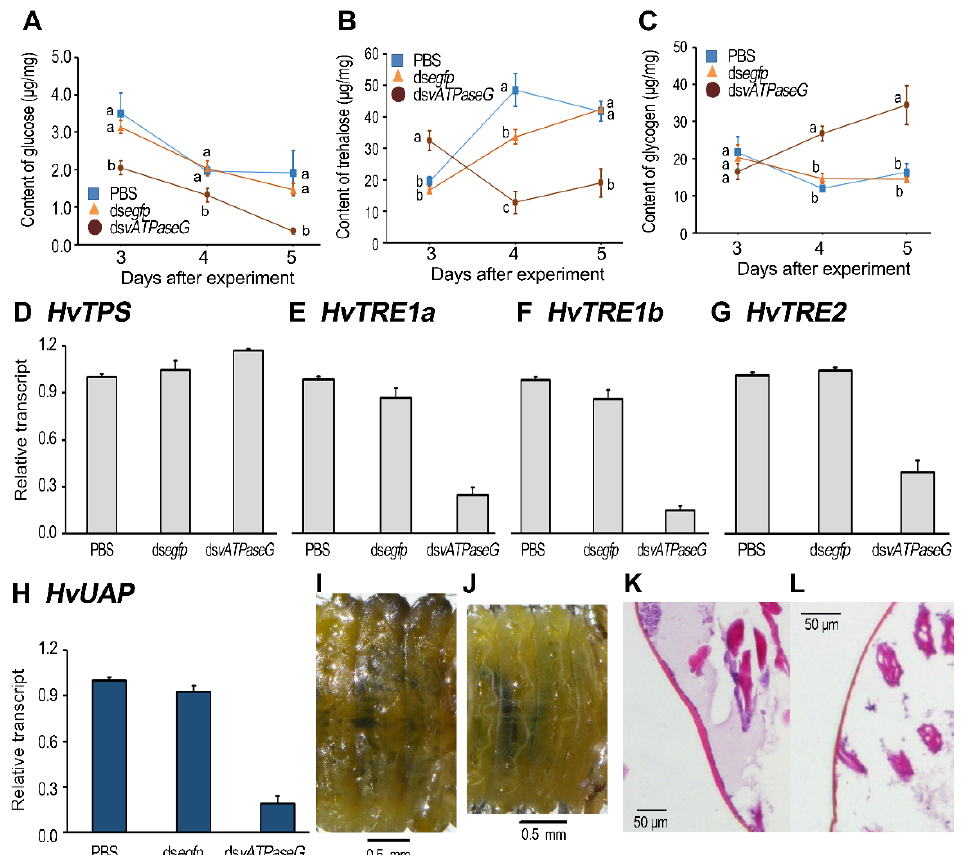
Figure 5. Knockdown of HvvATPaseG affects sugar contents in Henosepilachna vigintioctopunctata . The newly-ecdysed final instar larvae had ingested PBS-, ds egfp -, and ds vATPaseG -dipped leaves for three days. The specimens 3, 4 and 5 days after experiment were collected and the contents of glucose, trehalose and glycogen were determined ( A – C ). The expression levels of a trehalose biosynthesis gene ( HvTPS ), three trehalose degradation genes ( HvTRE1a , HvTRE1b and HvTRE2 ) and a chitin biosynthesis gene ( HvUAP ) were tested ( D – H ). Relative transcripts are the ratios of relative copy numbers in treated individuals to PBS-fed controls, which are set as 1. The bars represent values ( ± SE). Different letters indicate significant difference at p value < 0.05 using analysis of variance with the Tukey-Kramer test. The body cuticle was almost transparent in the ds vATPaseG -treated larvae, in contrast to ds egfp -ingested ones ( J vs. I ). The hematoxylin-eosin (HE) staining shows that the cuticle in the head capsule from PBS- and ds egfp -fed larvae are thicker ( K ) than that from ds vATPaseG -fed larvae ( L ).